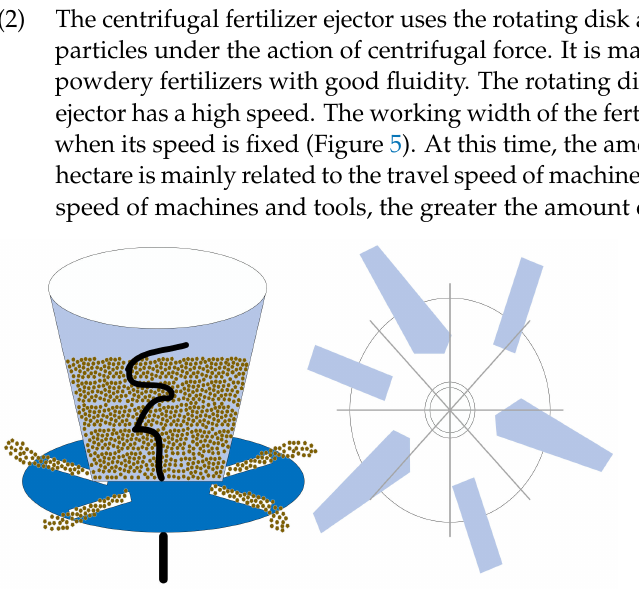
(2) The centrifugal fertilizer ejector uses the rotating disk at the bottom to scatter fertilizer particles under the action of centrifugal force. It is mainly applicable to granular and powdery fertilizers with good fluidity. The rotating disk at the bottom of the fertilizer ejector has a high speed. The working width of the fertilizer ejector will be determined when its speed is fixed (Figure 5). At this time, the amount of fertilizer discharged per hectare is mainly related to the travel speed of machines and tools. The faster the travel speed of machines and tools, the greater the amount of fertilizer discharged [98,99].